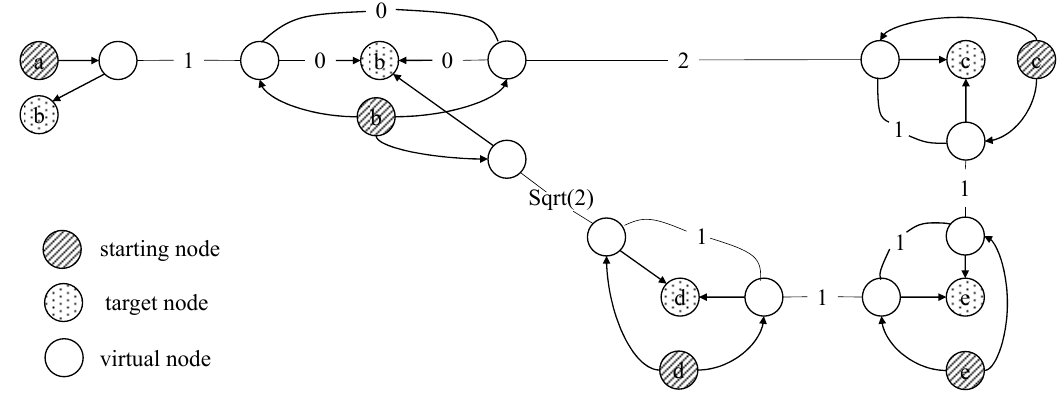
( b ) The target node Figure 5. Starting node and target node.